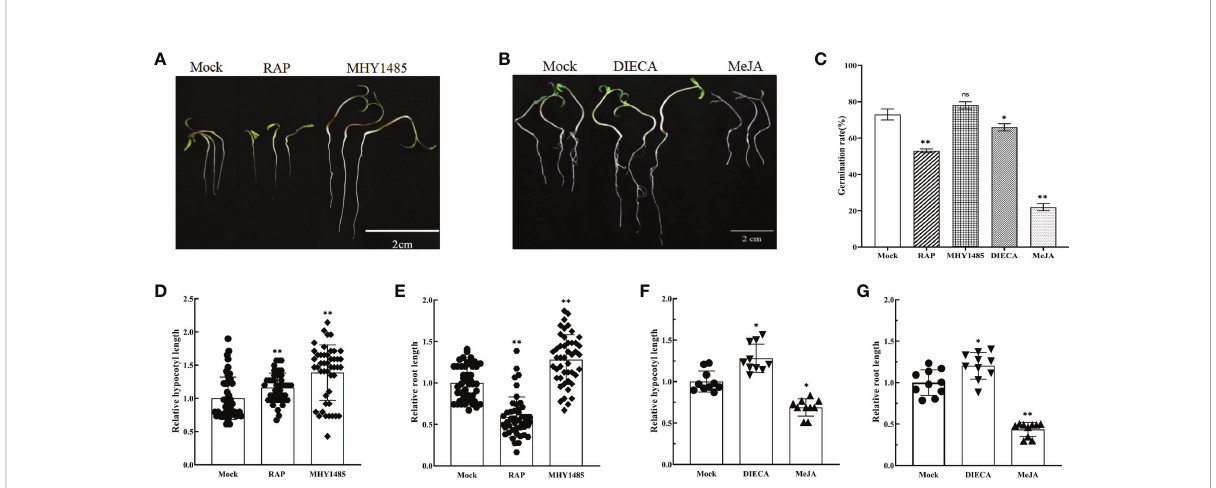
FIGURE 4 Effects of external application of RAP, MHY1485, DIECA and MeJA on tomato germination, relative hypocotyl length and root length. (A) Effects of external application of RAP and MHY1485 on tomato seedlings. (B) Effects of external application of DIECA and MeJA on tomato seedlings. (C) Effects of external application of RAP, MHY1485, DIECA and MeJA on tomato germination rate. (D) Effects of external application of RAP and MHY1485 on tomato relative hypocotyl length. (E) Effects of external application of RAP and MHY1485 on tomato relative root length. (F) Effects of external application of DIECA and MeJA on tomato relative hypocotyl length. (G) Effects of external application of DIECA and MeJA on tomato relative root length. Errors are standard deviations for three biological replicates (n=3). Differences between means were analyzed for signi fi cance using Student ’ s t test, *P < 0.05, **P < 0.01. ns, no signi fi cant